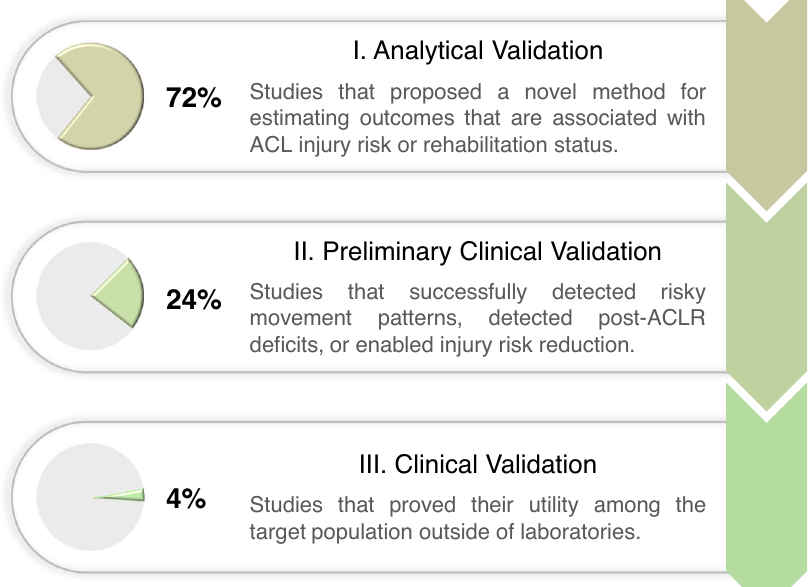
Fig. 5 Categorization of the included studies into three stages based on their readiness for deployment. Studies in stage I provided proof- of-concept evidence, studies in stage II demonstrated their clinical utilities, and studies in stage III proved their clinical